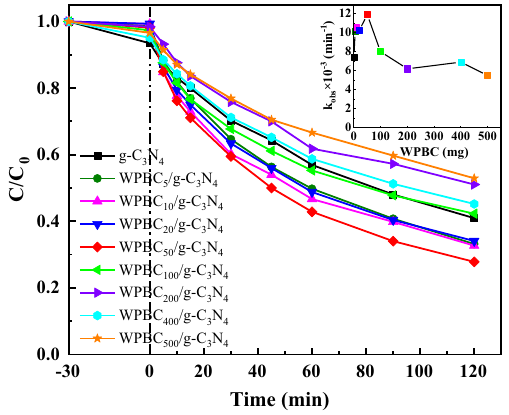
3 N 4 and WPBC 50 /g-C 3 N 4